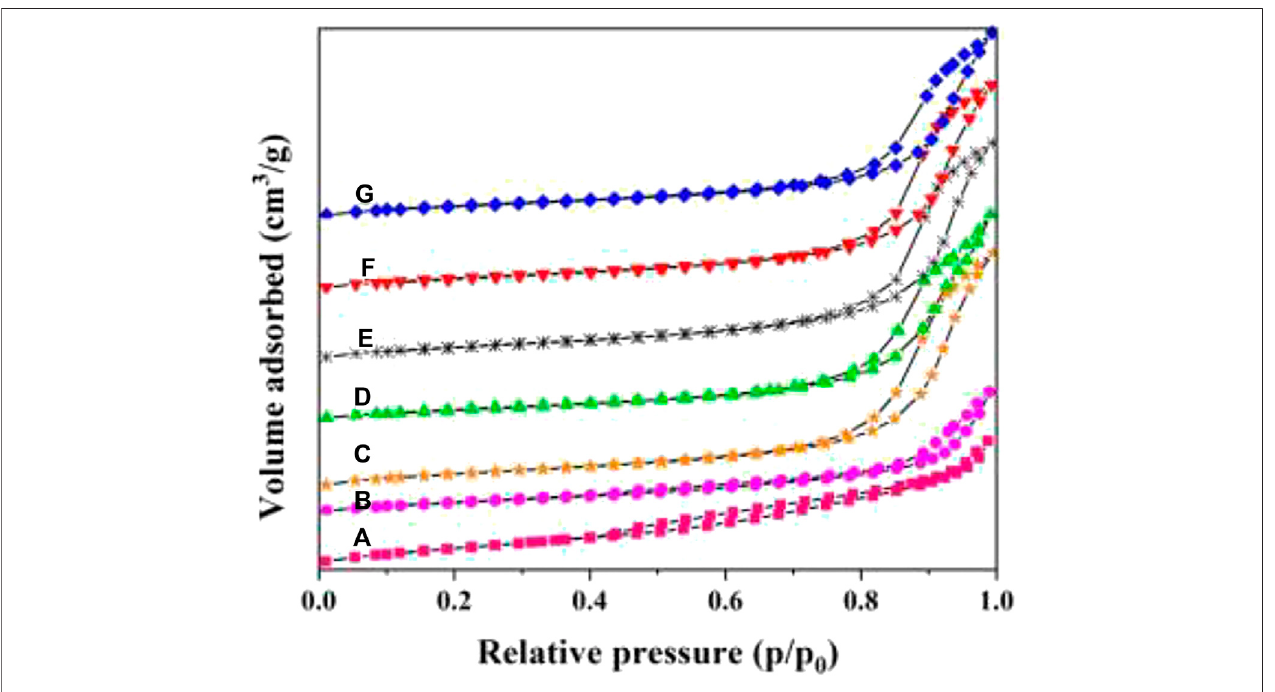
FIGURE 6 | Nitrogen adsorption – desorption isotherms of 3DOM catalysts. (A) ZrTiO 4 ; (B) W 1 MnO δ /ZrTiO 4 ; (C) W 1 CeO δ /ZrTiO 4 ; (D) W 1 CeMnO δ /TiO 2 ; (E) W